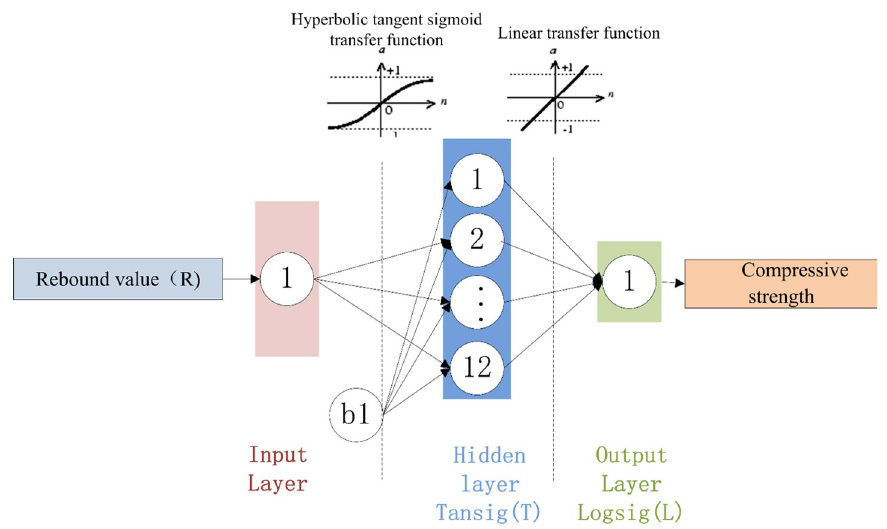
Fig 19. Optimal BPNN structure with one input parameter (R).